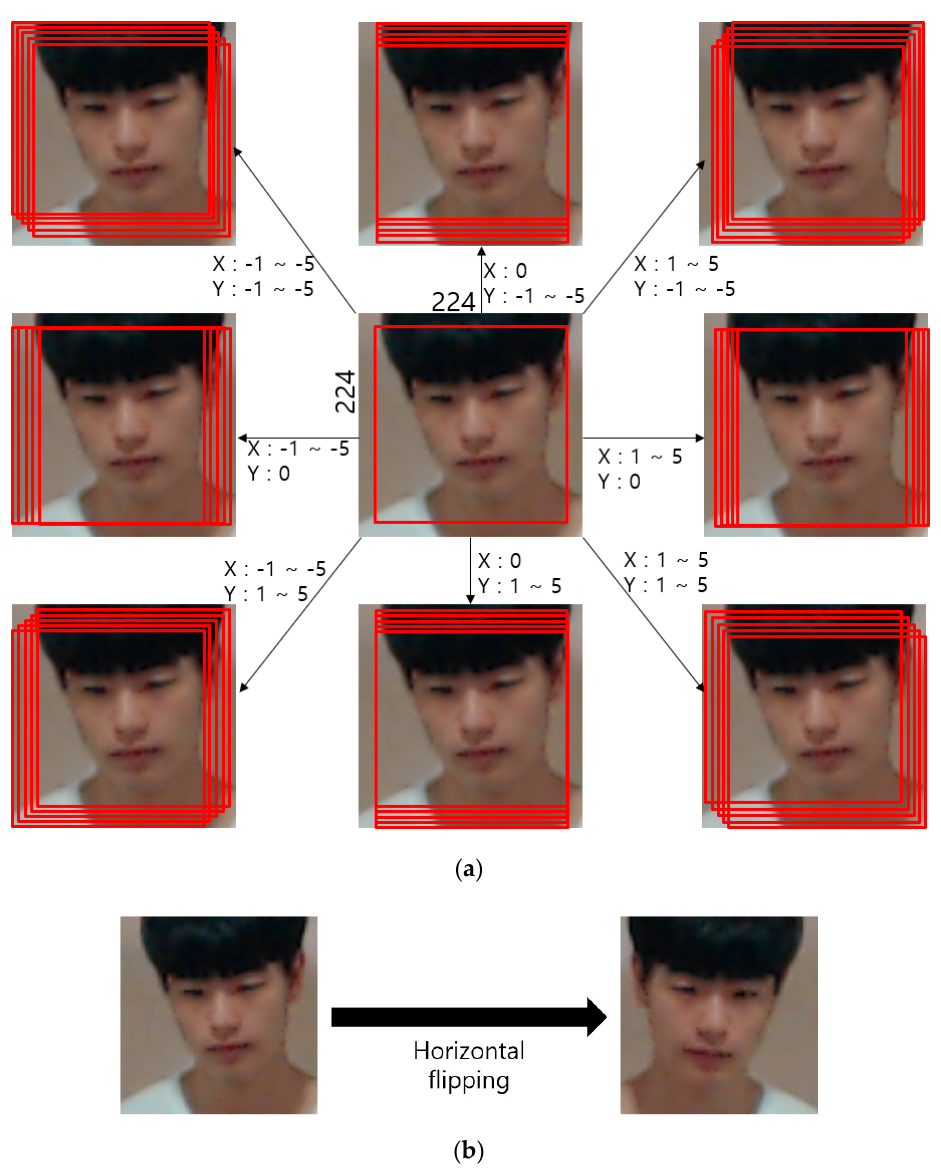
Figure 5. Data augmentation method involving ( a ) image translation and cropping and ( b ) horizontal flipping.